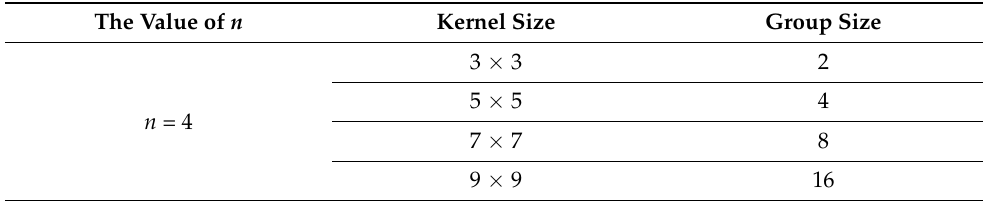
Table 2 records the kernel size and group size used in the experiment when n = 4. Table 2. The kernel size and group size when n =